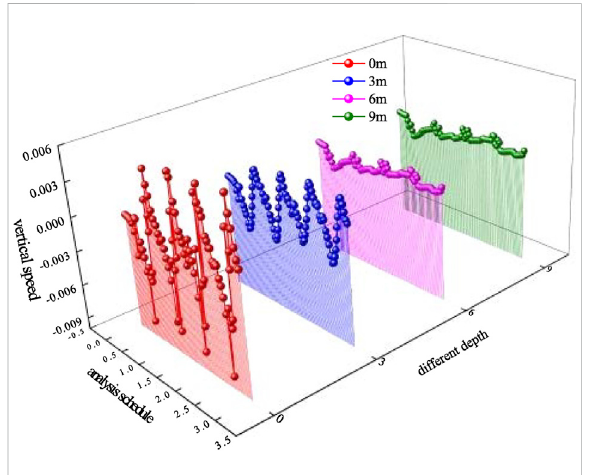
FIGURE 11 Vibration rule of the vertical velocity of feature points at different depths of midpoint cross-section of the roadbed.